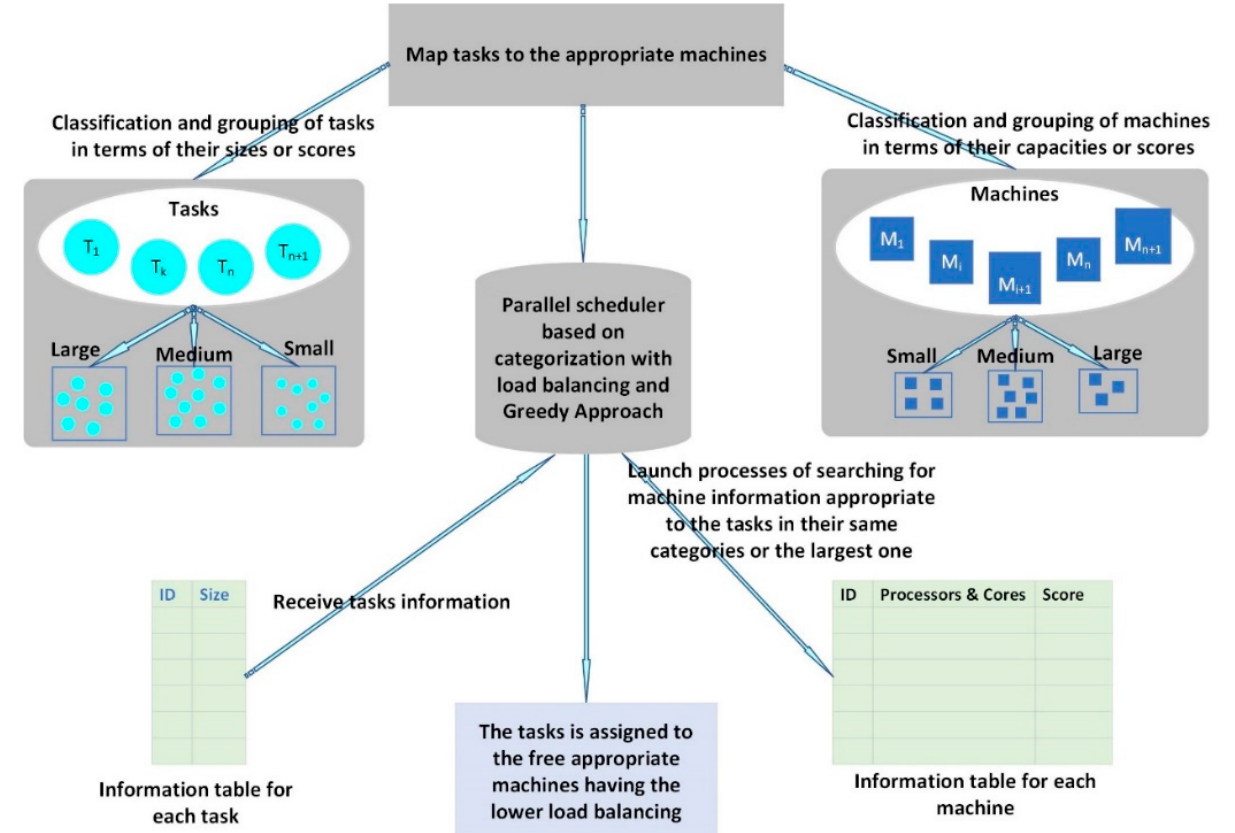
Figure 3. Operating mechanism for mapping tasks to appropriate devices.